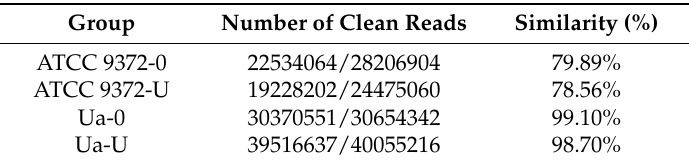
Table 1. The ratio statistics of